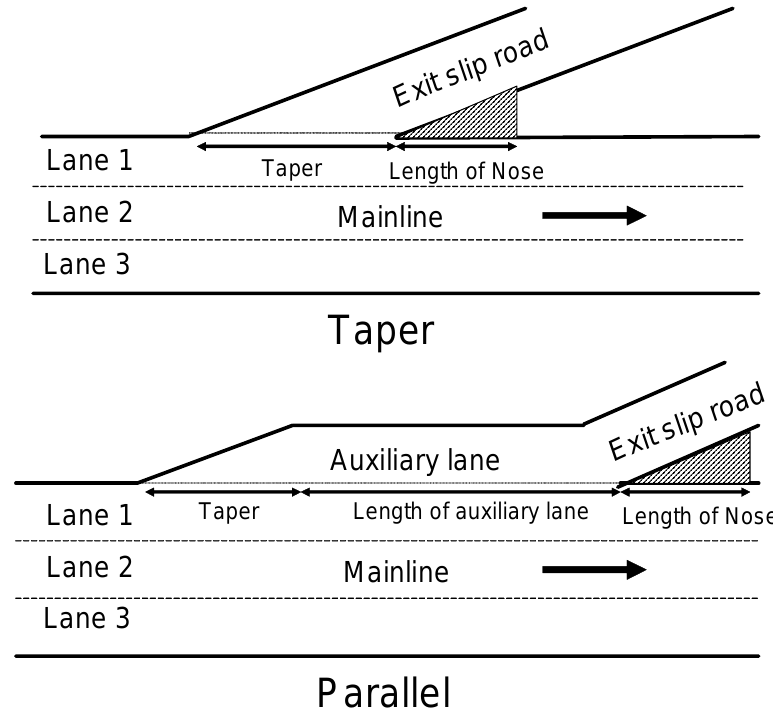
Figure 1. Two basic diverge designs in the UK With the Taper diverge, drivers wishing to leave the motorway should stay in lane 1 prior to the diverge, and then move directly into the exit slip road. With the Parallel diverge, drivers wishing to leave the motorway should stay in lane 1 and then move into the auxiliary lane that feeds into the exit slip road. An auxiliary lane (sometimes called a parallel lane) provides extra capacity, reducing the risk of traffic blocking back onto the main carriageway. These two types of layout can be associated with a lane drop or double lane drop (Parallel only). A lane drop occurs when the number of lanes downstream of the diverge is less than the number of lanes upstream of the diverge. This is as a result of the inside mainline lane(s) feeding into the exit slip road. Lane drops are only usually provided when there is a high diverging proportion or when there is a high merging proportion requiring a lane gain upstream of the diverge. There may also be policy, layout or economic reasons for their